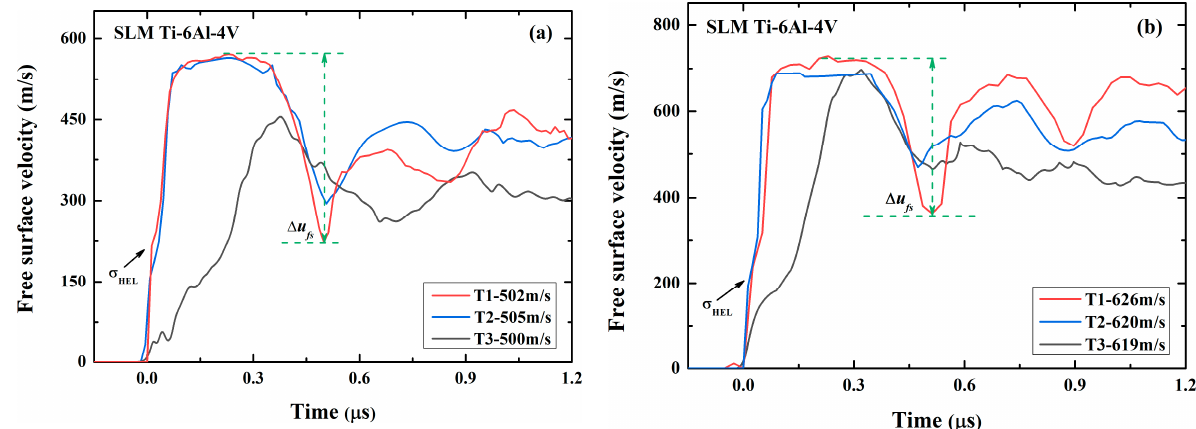
Figure 5. Free-surface particle velocity profiles of three SLM TC4 samples obtained in planar plate experiments at the impact velocity of ( a ) 500 m/s and ( b ) 620 m/s.